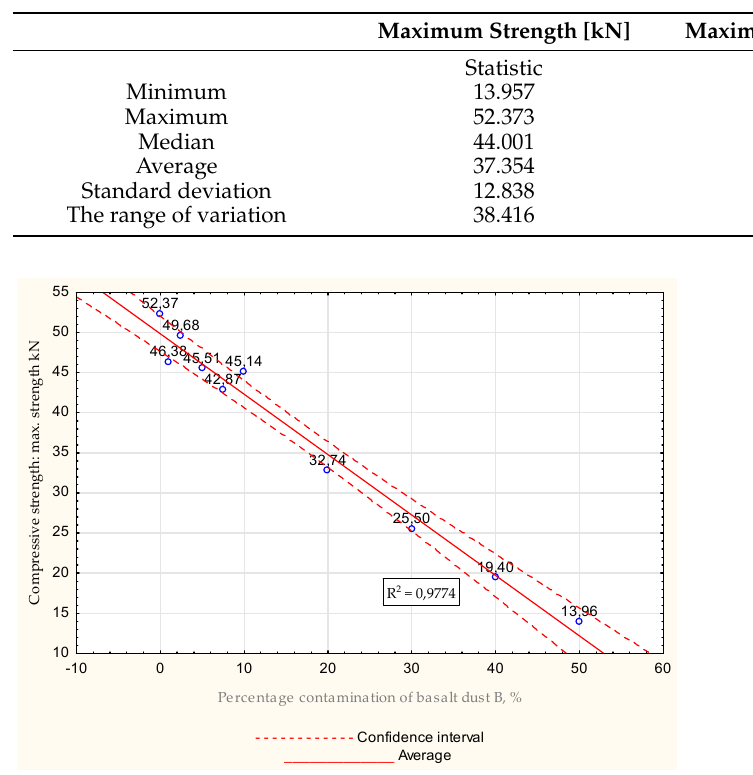
Figure 33. Average values obtained during compressive strength tests after 28 days for water − mix ratio = 0.6, max. strength.